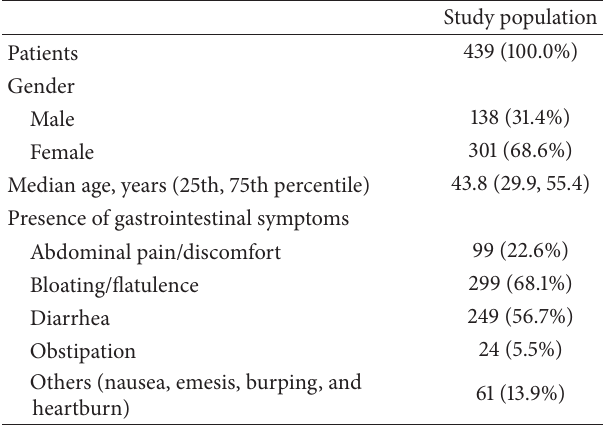
Table 1: Main demographic and clinical characteristics of the study